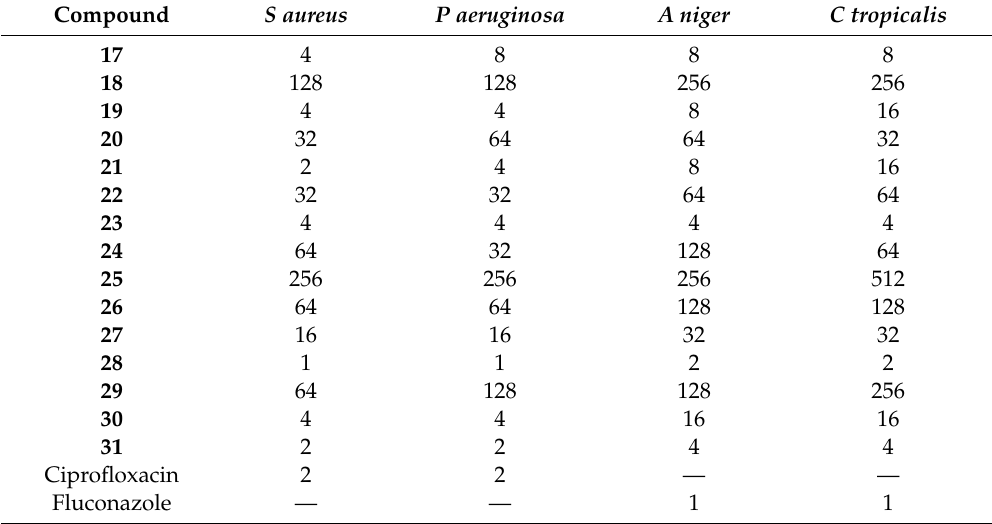
Table 1. Results of the antibacterial and antifungal activities of chalcones (MIC µ g / mL; 17 – 31 ). Compound